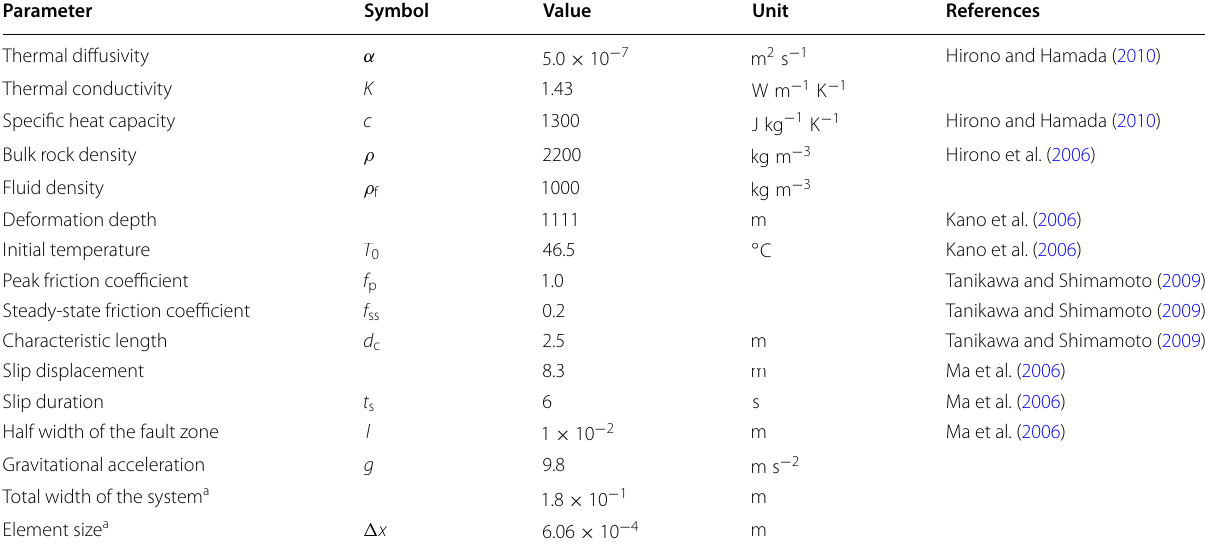
Table 1 Parameters used to calculate the example